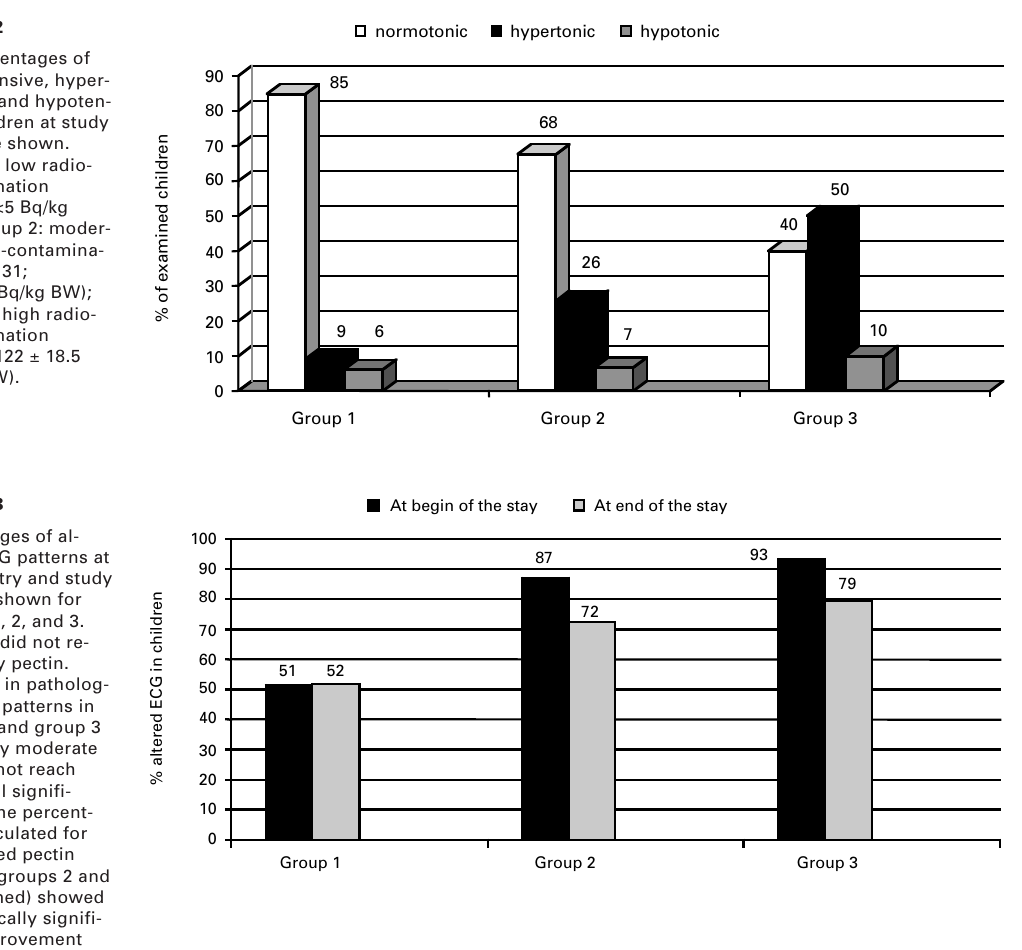
Figure 3 Percentages of al- tered ECG patterns at study entry and study end are shown for groups 1, 2, and 3. Group 1 did not re- ceive any pectin. Changes in patholog- ical ECG patterns in group 2 and group 3 were only moderate and did not reach statistical signifi- cance. The percent- ages calculated for the pooled pectin groups (groups 2 and 3 combined) showed a statistically signifi- cant improvement from baseline after the 16-day pectin course (p <0.05).